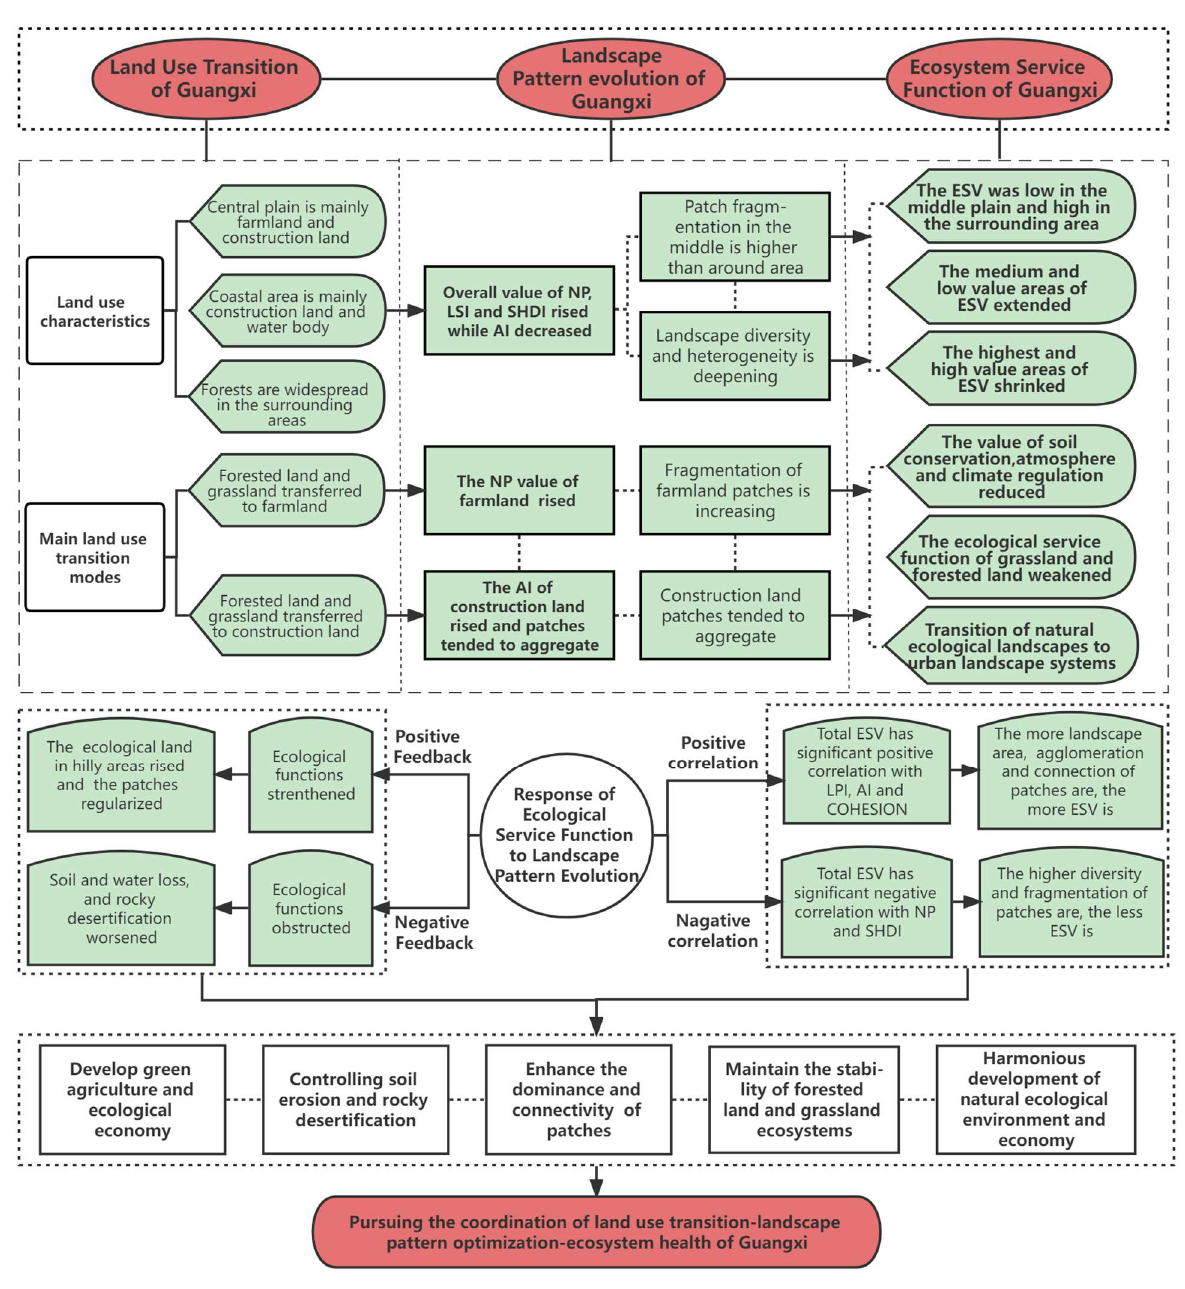
Figure 7. Empirical analysis framework of land use transition, landscape pattern evolution, Ecological Services Function response in Guangxi.